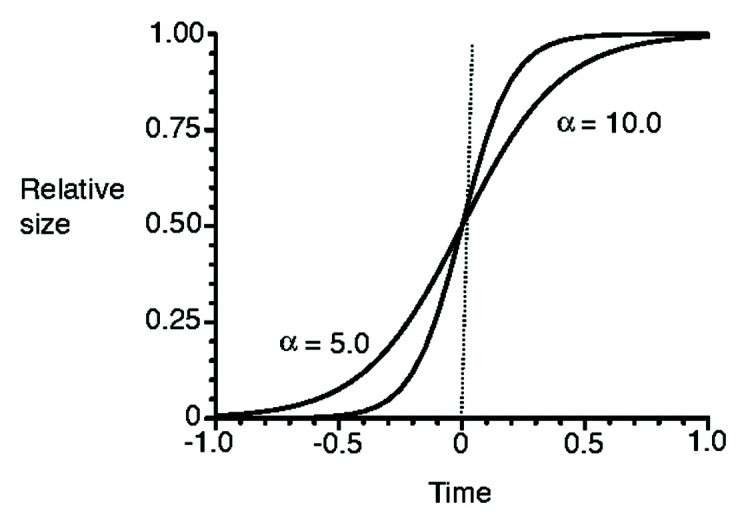
Sigmoid curves with two different values of α (redrawn from Onoda et al. (2011)).